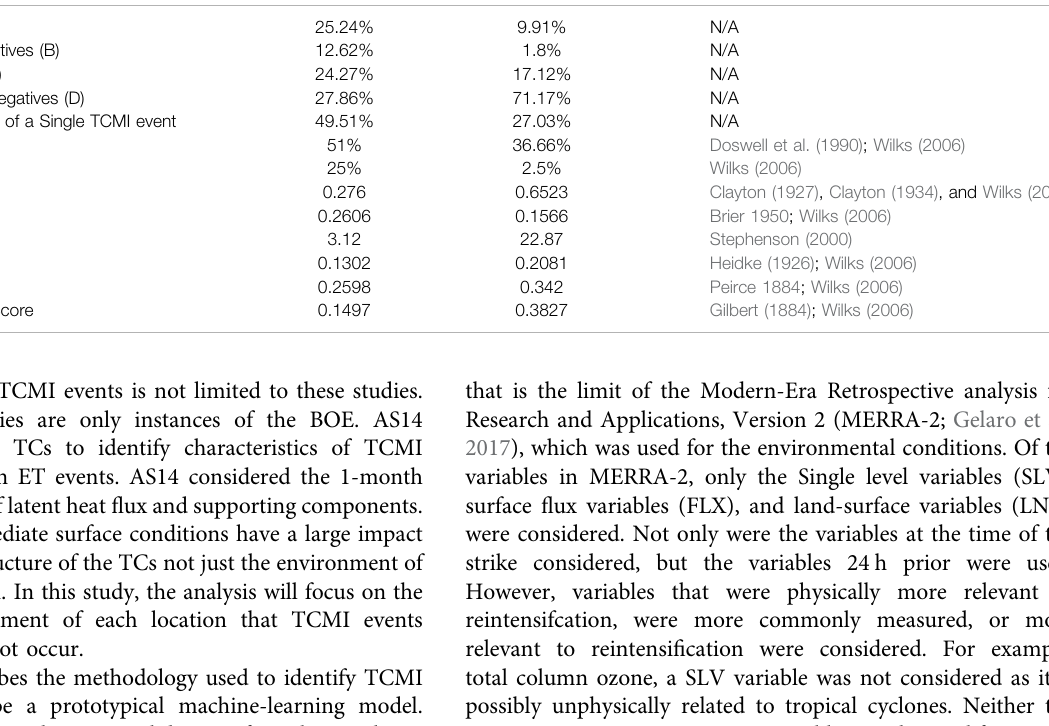
TABLE 2 | Contingency Analysis and Brier Score of the machine-learning model on the test dataset and training dataset.